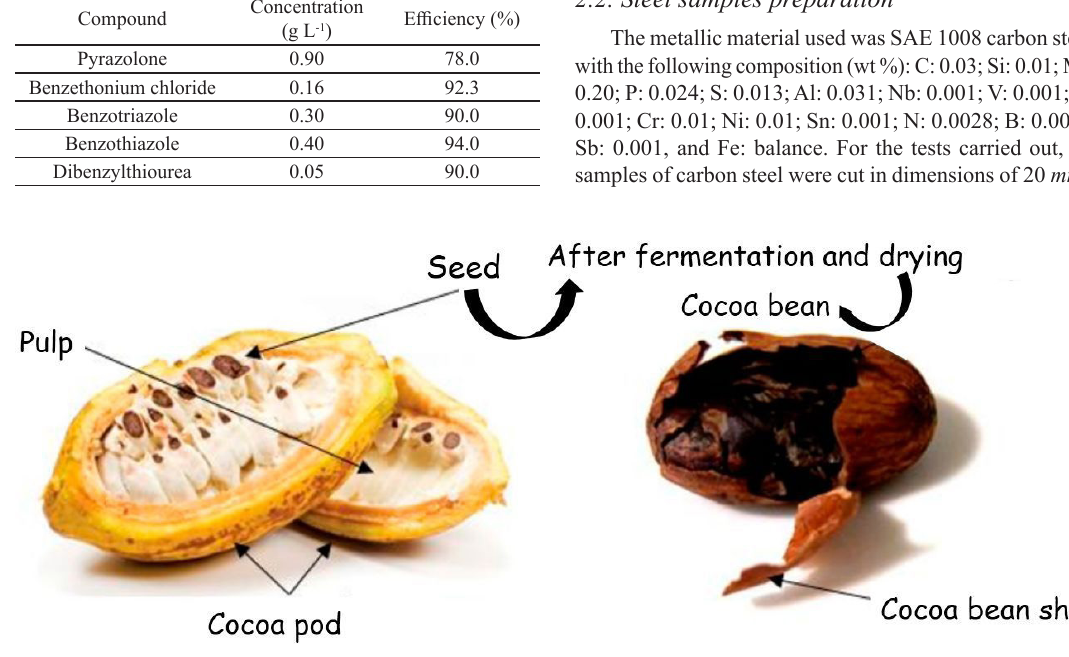
Figure 1. The fruit of cocoa and the cocoa shell. Adapted from Rojo-Poveda et al.